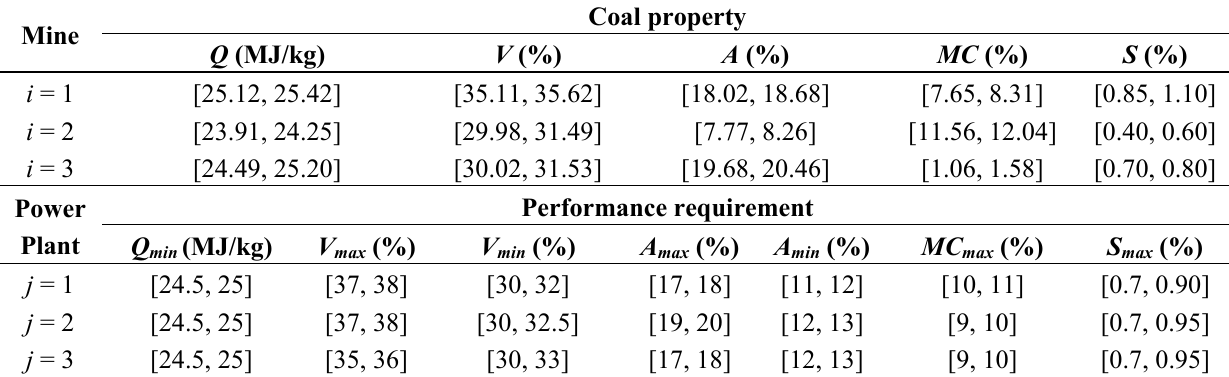
Table 2. Coal properties of the mines and performance requirements of the power plant. Mine